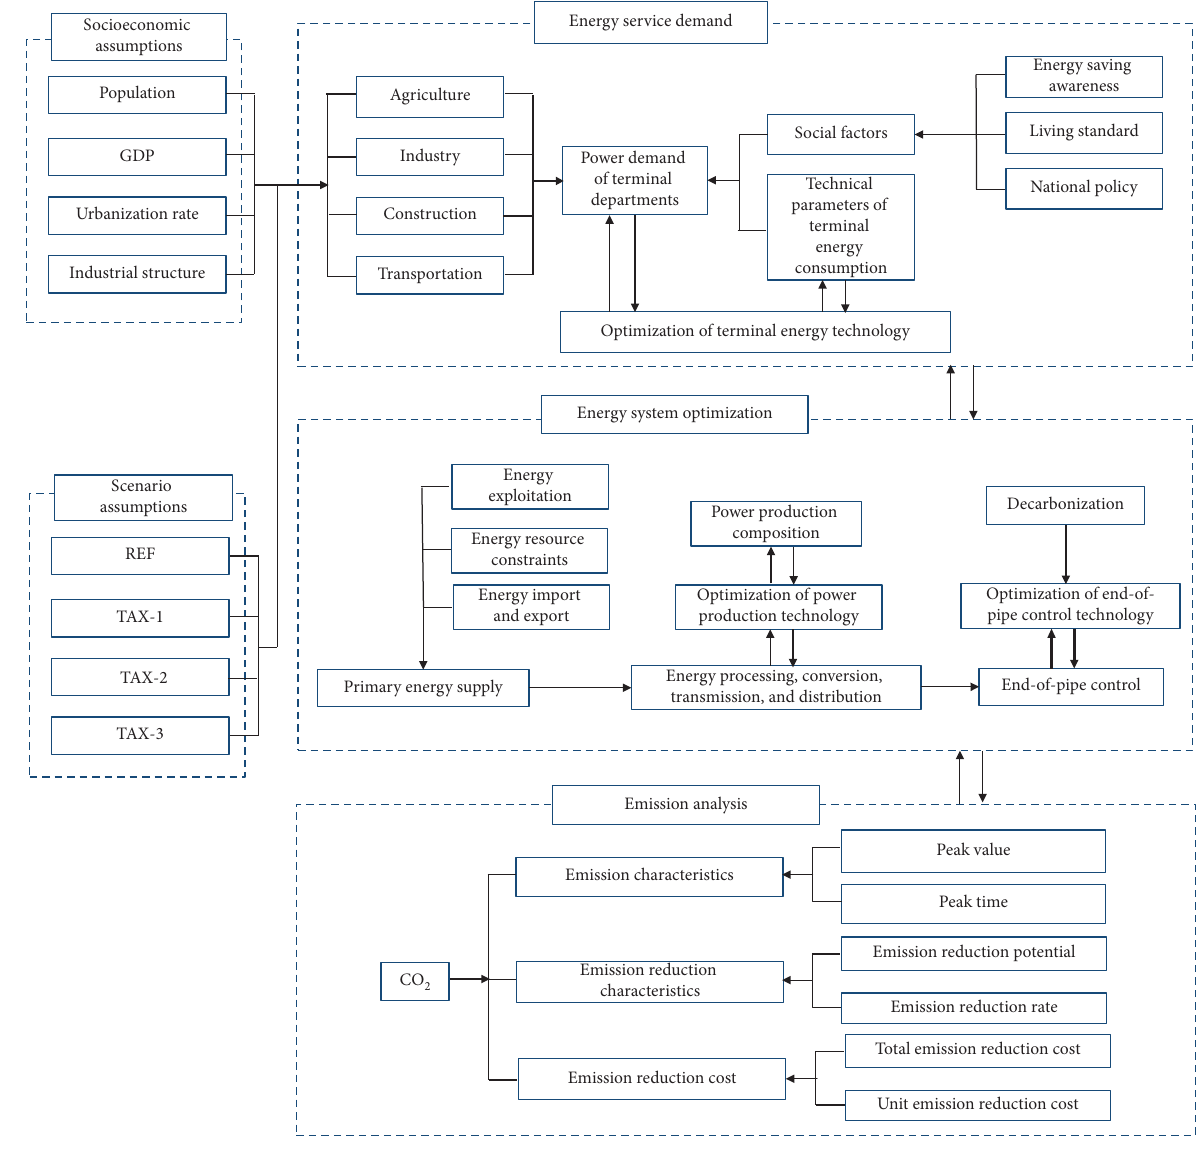
Figure 2: Flowchart of the proposed method. Table 1: Basic assumptions of the